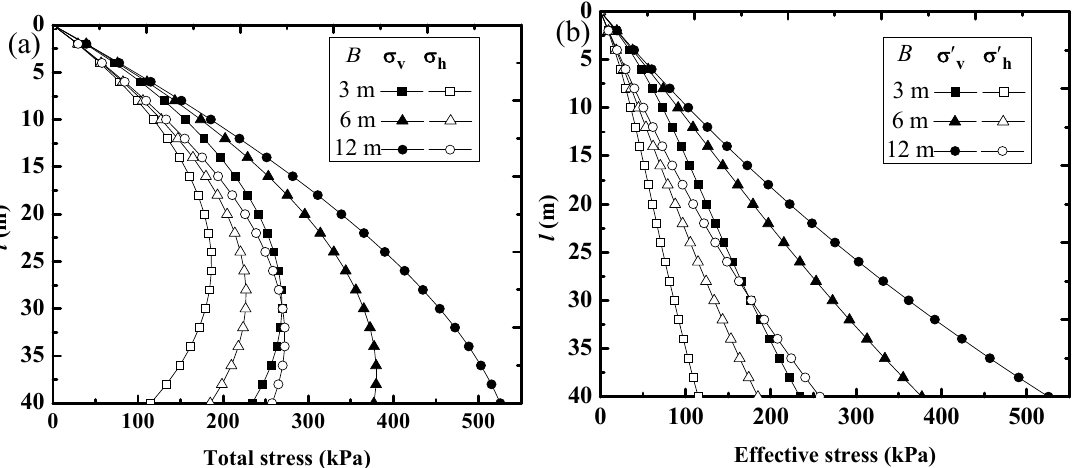
Figure 9. Distribution of the horizontal and vertical total ( a ) and effective ( b ) stresses along the full height of the backfilled stope with different stope widths when the filling operation ceases, predicted by the proposed solution (Equations (28)–(31)) by considering H = 40 m, m = 0.2 m/h, c v = 5 m 2 /h, γ = 20 kN/m 3 , γ w = 10 kN/m 3 , φ ’ = 20 ◦ , and K = K a .